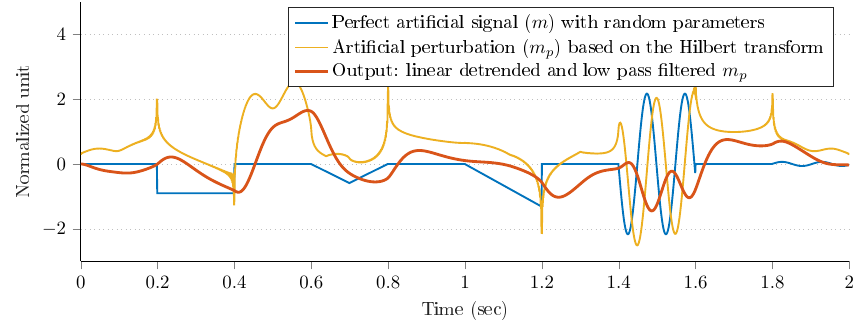
Figure 6. Demonstration of the proposed magnetic perturbation generator